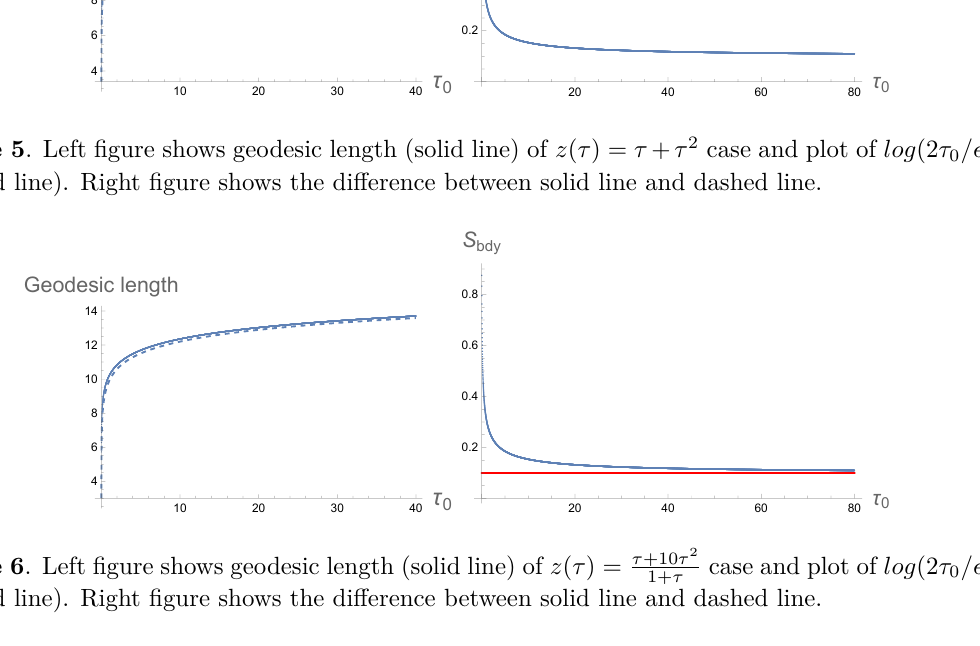
Figure 6 . Left figure shows geodesic length (solid line) of z ( τ ) = τ +10 τ 2 (dashed line). Right figure shows the difference between solid line and dashed